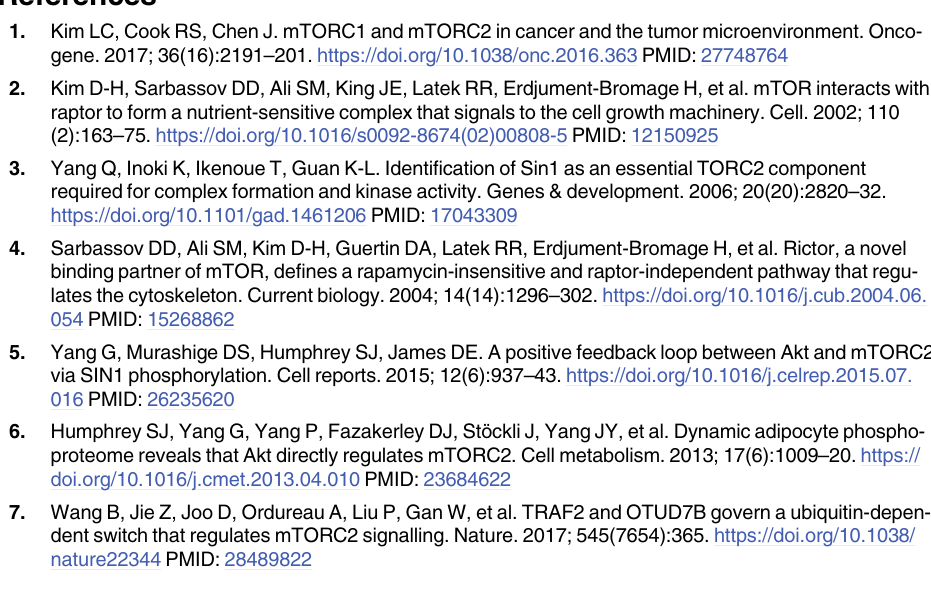
S10 Fig. Inferred mean concentration and standard errors of the model proteins based on analysing CCLE and iBAQ data for four representative cell lines. S1 Table. Reactions and rate equations of the PI3K/MTOR pathway model. S2 Table. Ordinary differential equations of the PI3K/MTOR pathway model. The reaction rates are given in S1 Table. The initial conditions are representative